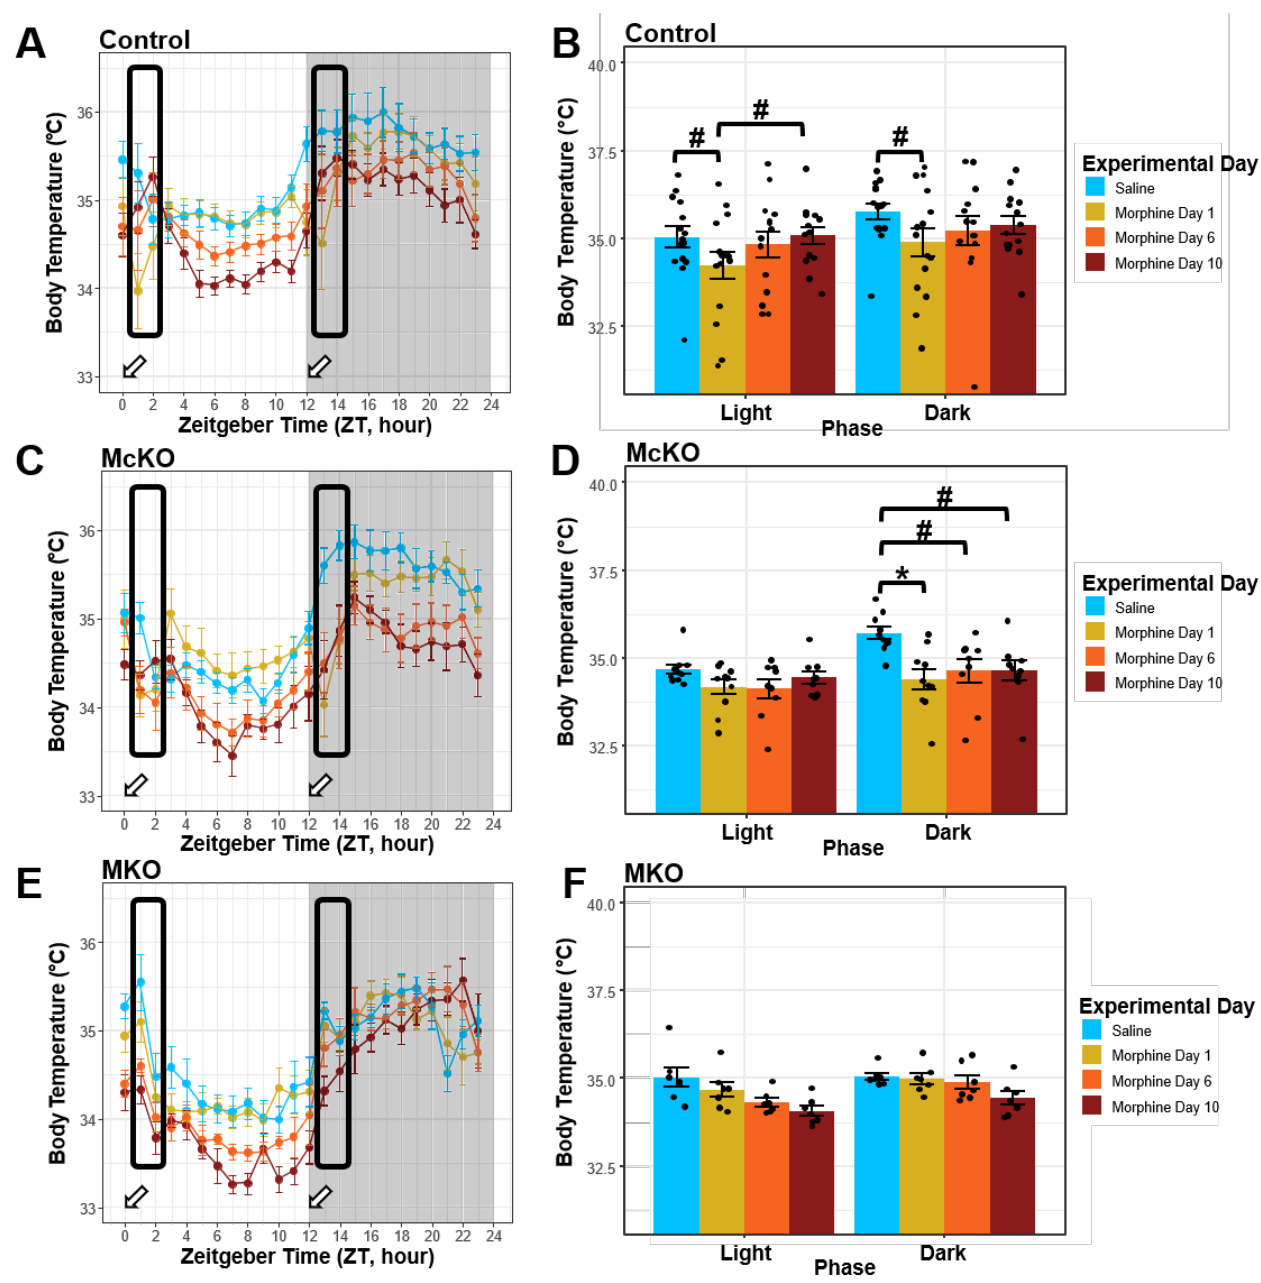
Figure 4. Control mice, but not McKO or MKO mice, developed tolerance to the hypothermic effects of morphine. ( A , B ) Control mice ( n = 14 – 15) treated with chronic morphine exhibited morphine- induced hypothermia following acute but not chronic morphine exposure. Body temperature was measured 2 – 3 h following a 20 mg/kg i.p. morphine injection at ZT0 and ZT12. ( C , D ) McKO mice ( n = 9 – 10) treated with morphine-induced hypothermia in the dark but not in the light. Body temperature was measured 2 – 3 h following a 20 mg/kg i.p. morphine injection at ZT0 and ZT12. ( E , F ) MKO mice ( n = 7) exhibited minimal body temperature changes following both acute and chronic morphine administration. Body temperature was measured 2 – 3 h following a 20 mg/kg i.p. morphine injection at ZT0 and ZT12. Three-way ANOVA (phase × genotype × experimental day) with a Holm – Bonferroni post hoc adjustment was performed on all pairwise comparisons (# p < 0.05, * p < 0.01). Timing of injections indicated by the white arrows. Data presented as mean ± SEM.